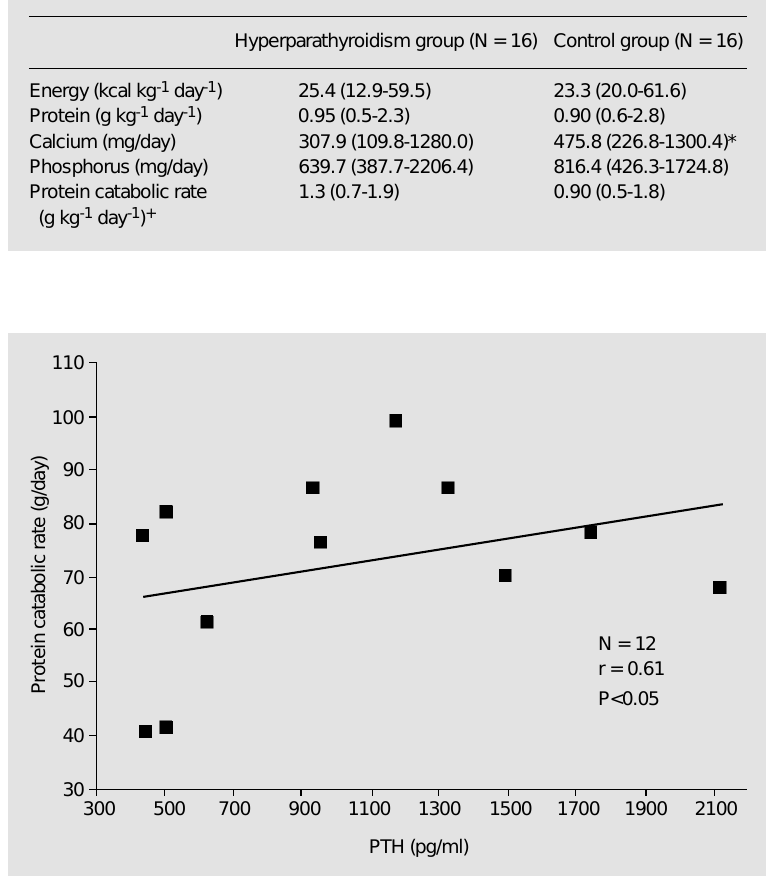
Table 3 - Dietary intake and protein catabolic rate. Data are reported as median and range (in parentheses). + N = 12. * P<0.05 vs control group (Mann-Whitney U-test).